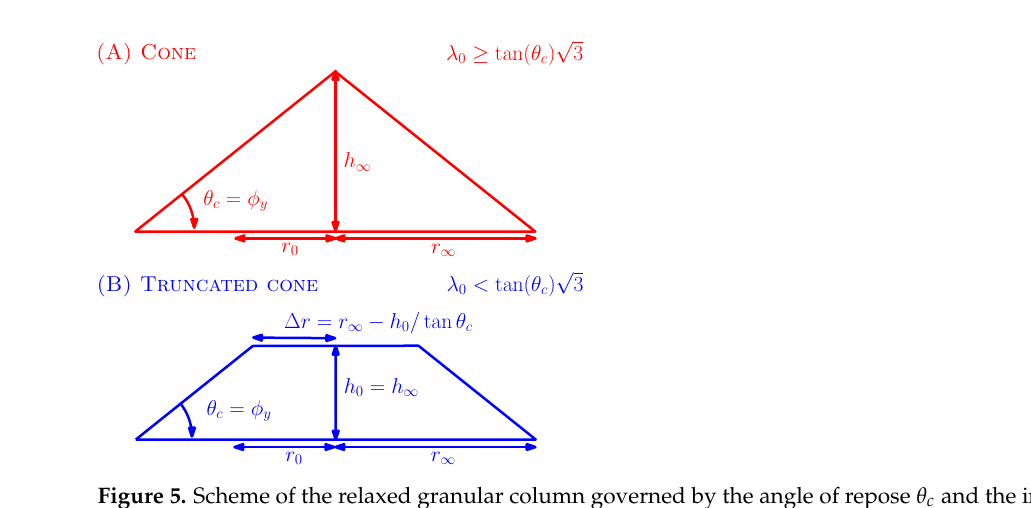
Figure 5. Scheme of the relaxed granular column governed by the angle of repose θ c and the initial aspect ratio λ 0 under the quasistatic deformation